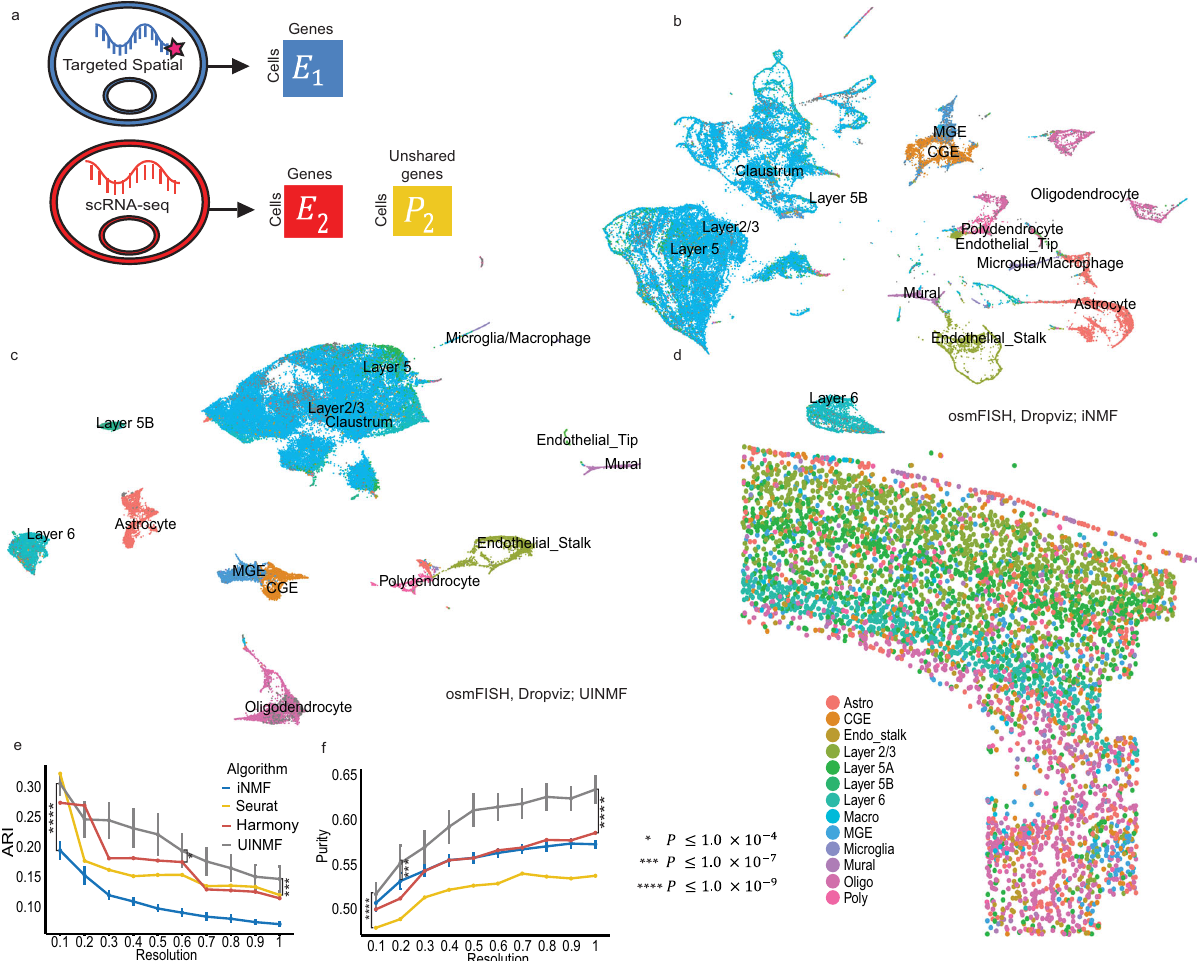
Fig. 5 Incorporating additional genes improves integration with osmFISH data. a Schematic of data matrices from osmFISH and scRNA-seq. The osmFISH dataset measures only 33 genes, while the scRNA-seq dataset has many unshared genes that are incorporated during UINMF integration. b UMAP plot of osmFISH and scRNA integration with iNMF using only shared genes. c UMAP using UINMF to incorporate an additional 2,000 genes. Both ( b ) and ( c ) are annotated using the original scRNA-seq labels and either the iNMF ( b ) or UINMF ( c ) derived clusterings. d The spatial arrangement of cell types matches the known tissue structure of the cortex ( e – f ). ARI ( e ) and purity ( f ) metrics for iNMF ( P < 2.2 × 10 − 16 , P = 7.078 × 10 − 8 ), UINMF, Seurat v3 ( P = 2.505 × 10 − 9 , P < 2.2 × 10 − 16 ), and Harmony ( P = 2.982 × 10 − 5 , P = 1.744 × 10 − 15 ). Statistical signi fi cance was evaluated using a paired, one- sided Wilcoxon test ( n = 200 values for each test, with each sample having 10 values across 10 resolutions). For nondeterministic algorithms, data are presented as mean values + / −